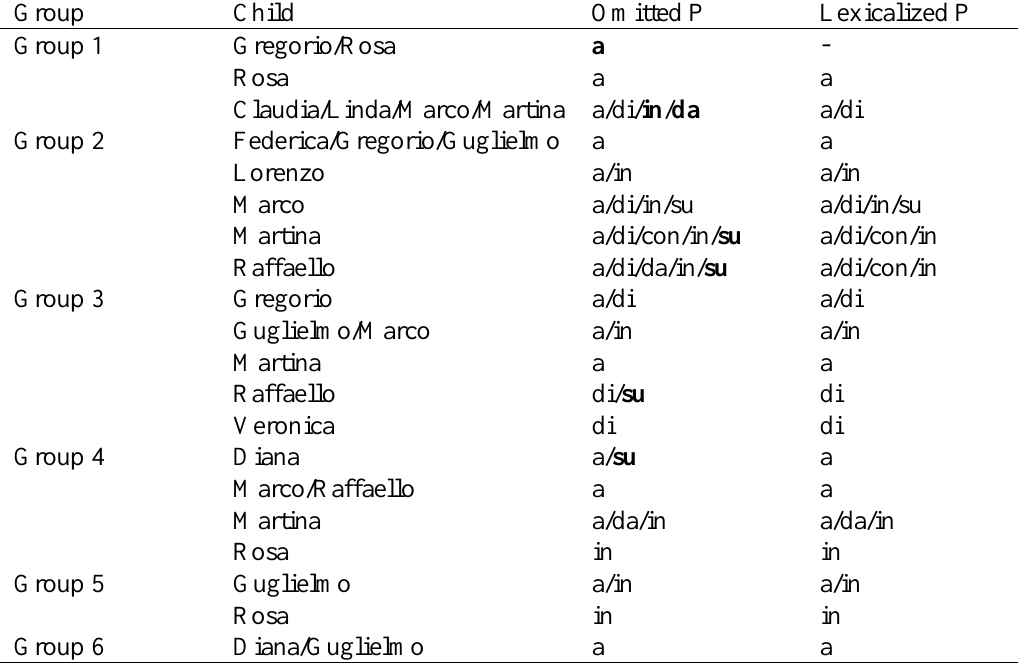
Table 11 . Omitted and lexicalized prepositions per child across MLU Groups Group Child Omitted P Group